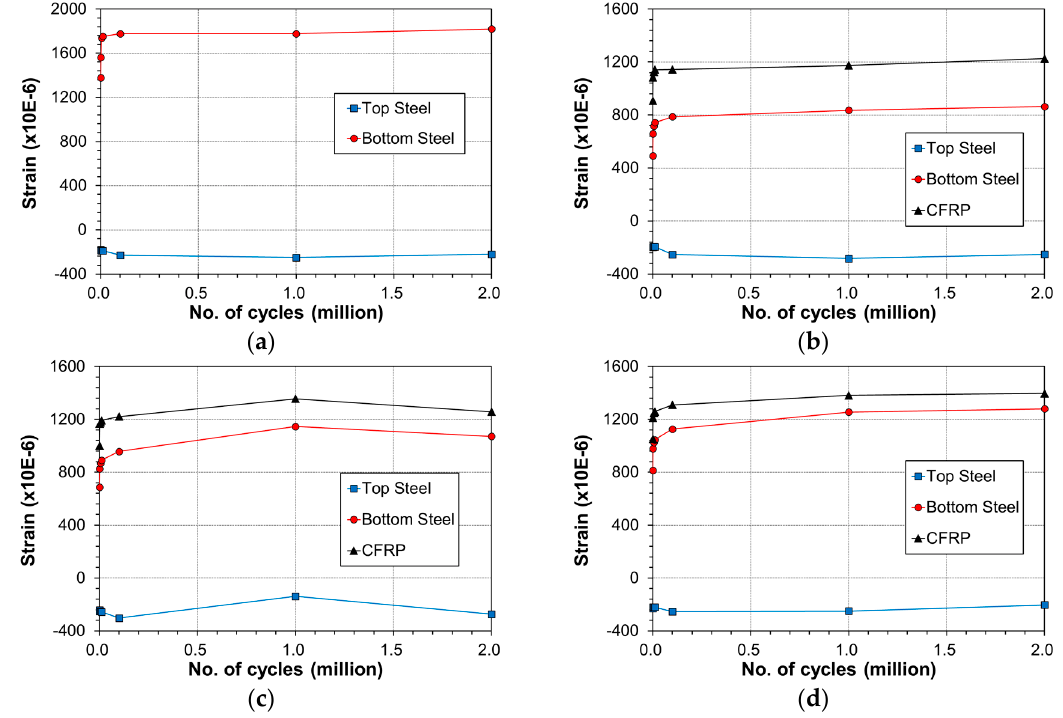
Figure 16. Variation of strain across the beam at mid-span with number of cycles: ( a ) control; ( b ) E-OX-1-40-67%; ( c ) E-OX-1-40-80%; ( d ) E-OX-1-40-93%.